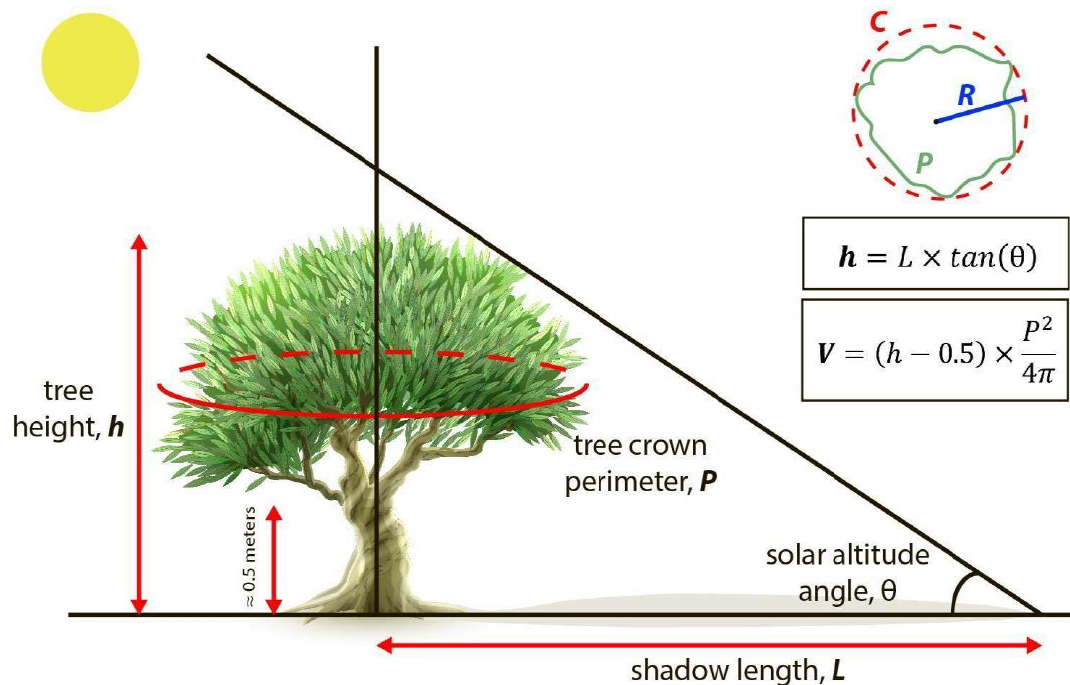
Figure 5. Illustration of the approximated biovolume in olive trees estimated from the automatic retrieval of tree crown and tree shadow polygons from deep neural networks (Mask R-CNN) applied on RGB or multispectral Unmanned Aerial Vehicle imagery. The volume of the tree canopy was approximated to a cylinder with a base of equal perimeter ( P = C ) to the polygon of the tree crown and with a height equal to the height ( h ) of the tree estimated from the length ( L ) of its shadow minus 0.5 m corresponding to the height of the unbranched trunk at the bottom. V: approximated biovolume; P: tree crown perimeter, equal to the circumference ( C ) of the cylinder base; L : length of tree shadow; θ : solar altitude angle; h : tree height. The olive tree picture was designed by macrovector and downloaded from www.freepik.com. (accessed on 25 February